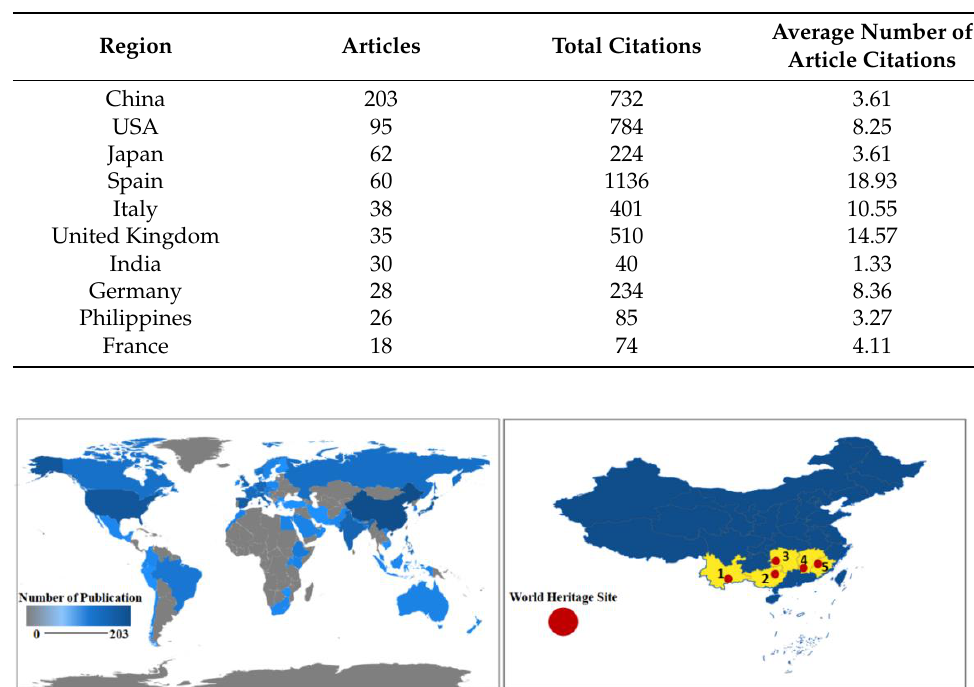
Table 2. Top 10 countries in terms of article number.